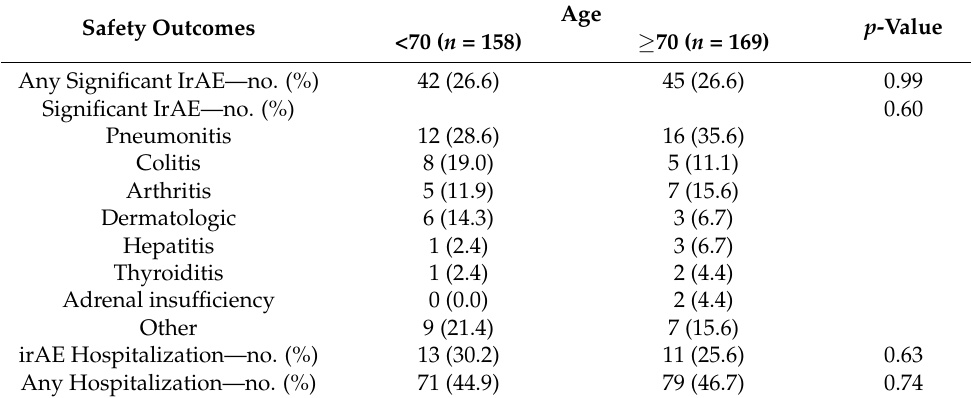
Table 3. Summary data of the safety outcomes based on age.